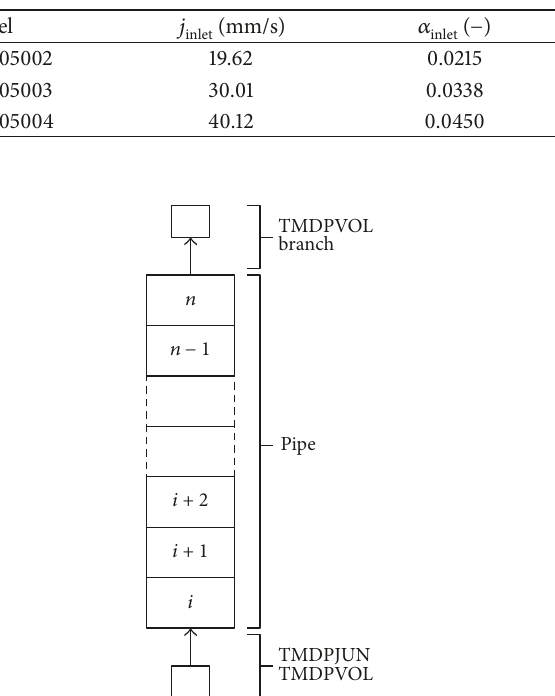
Table 1: Flow conditions for the different scenarios.